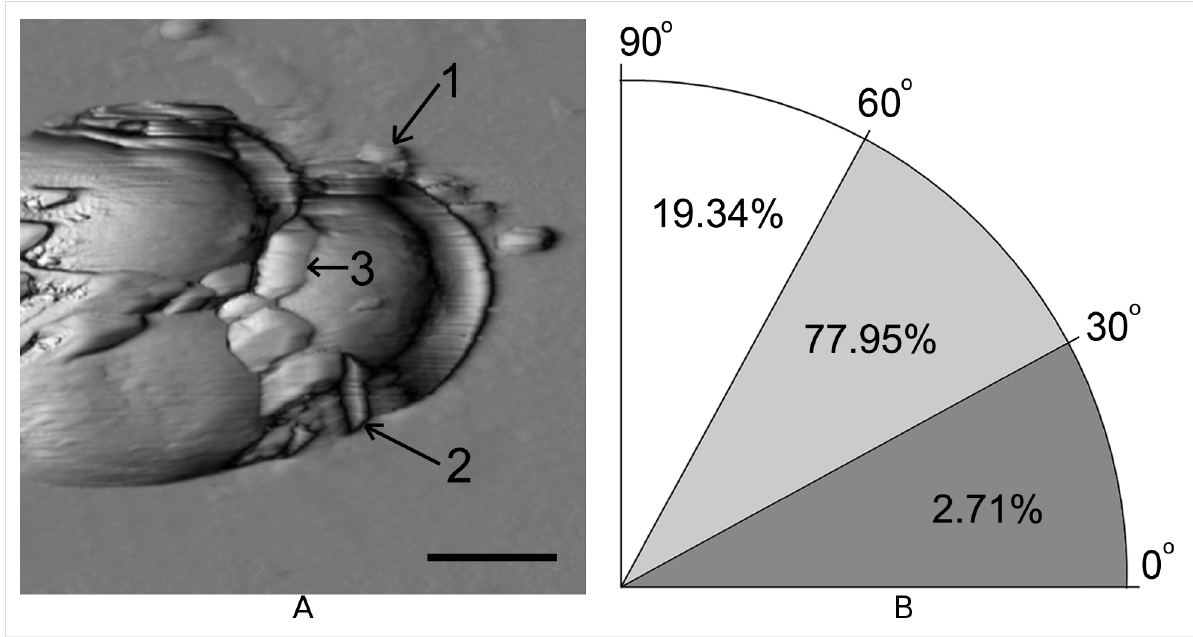
Figure 2: Distribution of IgG–Au conjugates on S. aureus cells: AFM image (a) and allocation of aggregates on a cellular surface according to binding area (b). Scale bar is 500 nm.